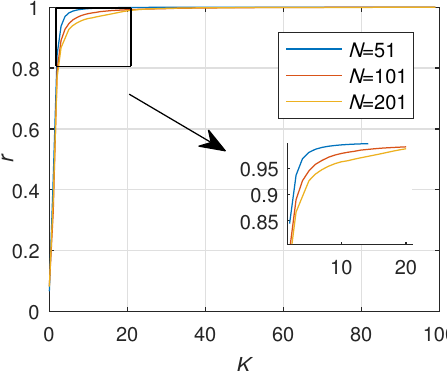
Figure 10. The stability of the weighted directed network when N is 51,101,201.